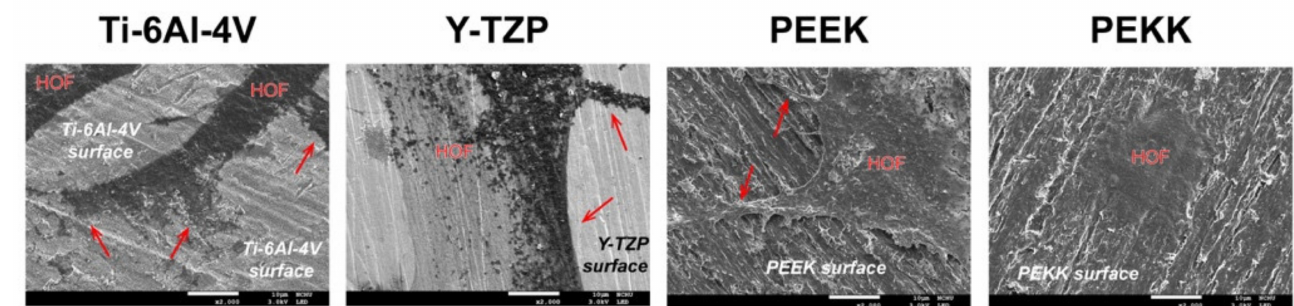
Figure 3. FE-SEM microphotographs obtained after 48 h, when HOF had adhered and proliferated on the surface of the abutment materials (Ti-6Al-4V, Y-TZP, PEEK, and PEKK). The scale bar is 10 µ m (original magnification × 2000). The arrows indicate the cell pseudopodia.